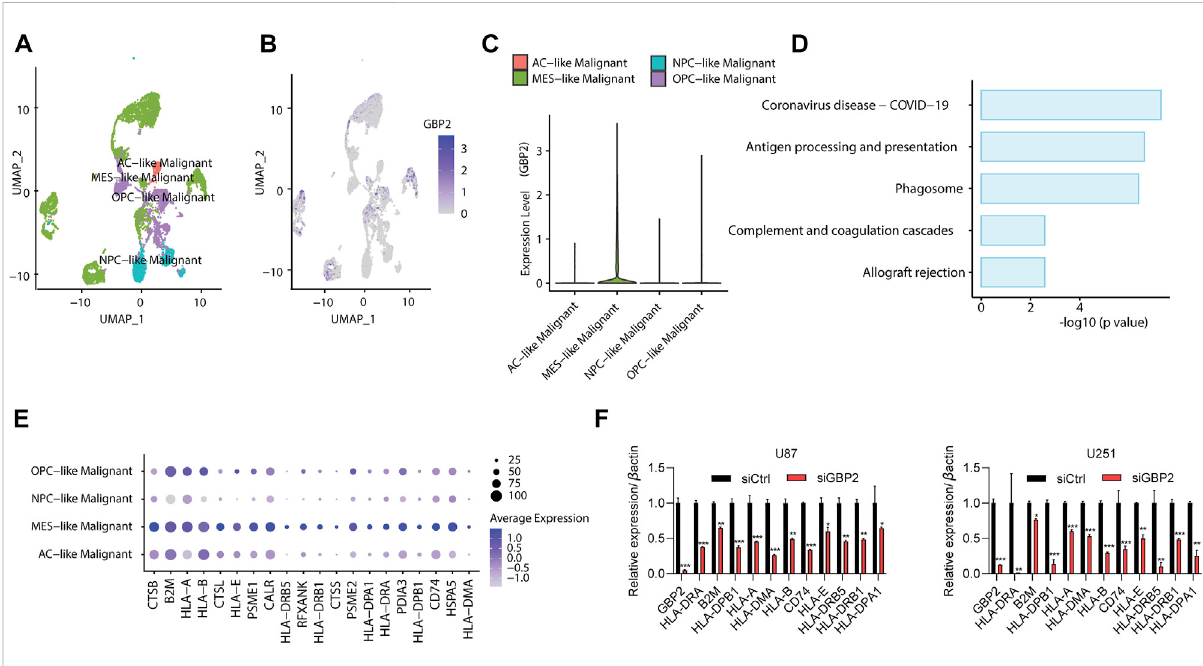
FIGURE 6 GBP2 expression in glioma microenvironment. (A) UMAP plot showing the subtype of malignant cells in glioma patients (GSE131928). (B,C) UMAP plot (B) and violin plot (C) showing the GBP2 expression among glioma subtypes. (D) KEGG pathway enrichment of highly expressed genes in GBP2-high (MES-like) malignant cells. (E) Dot plot showing antigen presentation genes across four subtype of glioma cells. (F) qRT-PCR analysis of indicatedgenesinU87andU251cellstransfectedwithsiCtrlandsiGBP2.Theexpressionofindicatedgeneswasadjustedtotheexpressionof β - actin. * p < 0.05. ** p < 0.01. *** p <